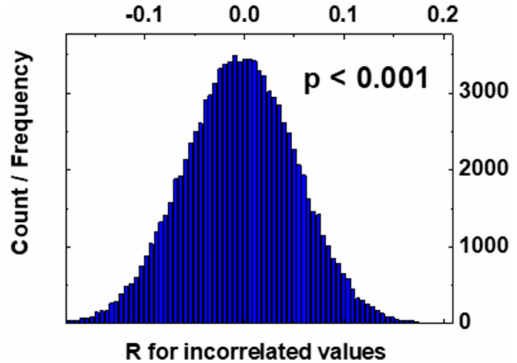
Figure 10. Histogram of the correlation between SO 2 and CO 2 .